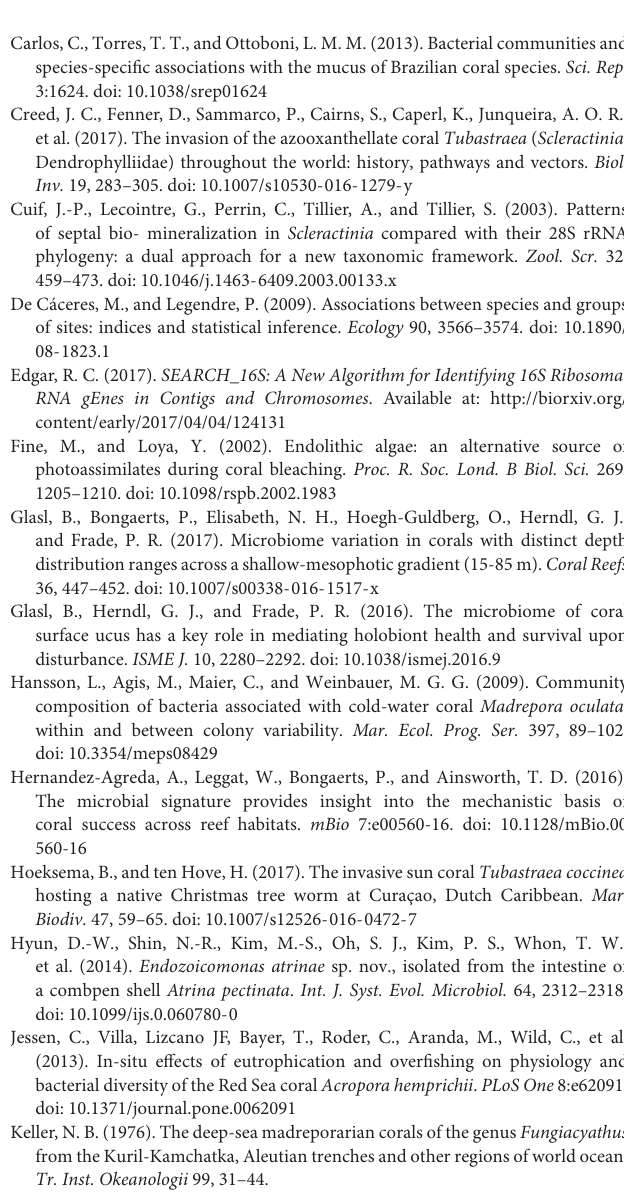
FIGURE S1 | The studied sun coral species Rhizopsammia goesi (right hand side) and Tubastrea coccinea (left hand side) (A) in situ on the same very shallow reef on Curaçao, Dutch Caribbean during daytime and (B) at night time, showing differences in polyp